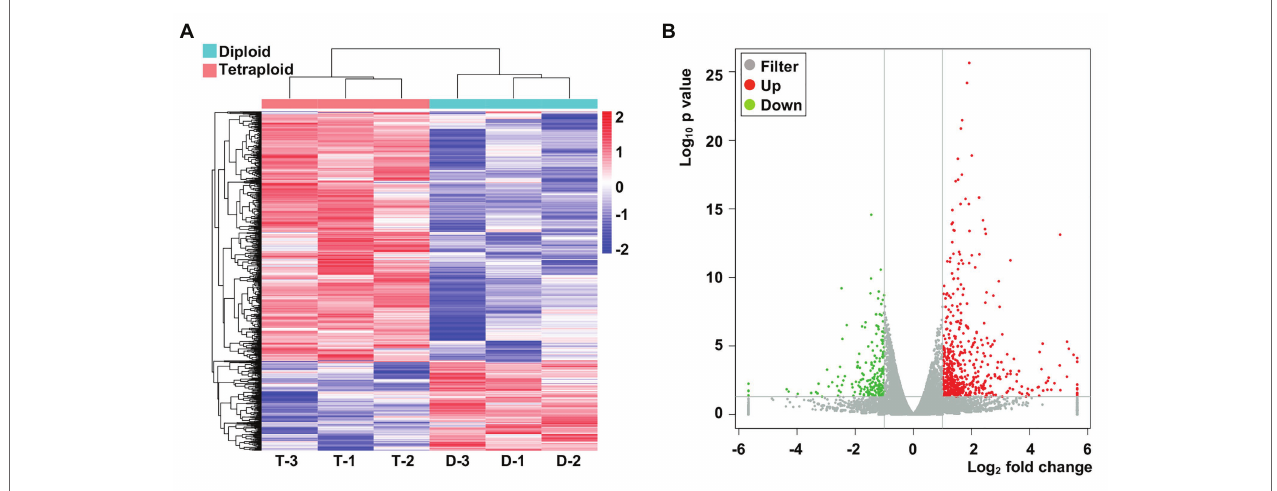
FIGURE 4 | The abundance of specifically expressed mRNA transcripts in the six barley samples and differentially expressed genes (DEGs). (A) Cluster of specifically expressed mRNAs, for which D-1,2,3 denote three biological replicates of diploid barley; T-1,2,3 denote three biological replicates of tetraploid barley. (B) Volcano of DEGs in the tetraploid barley comparing to the diploid